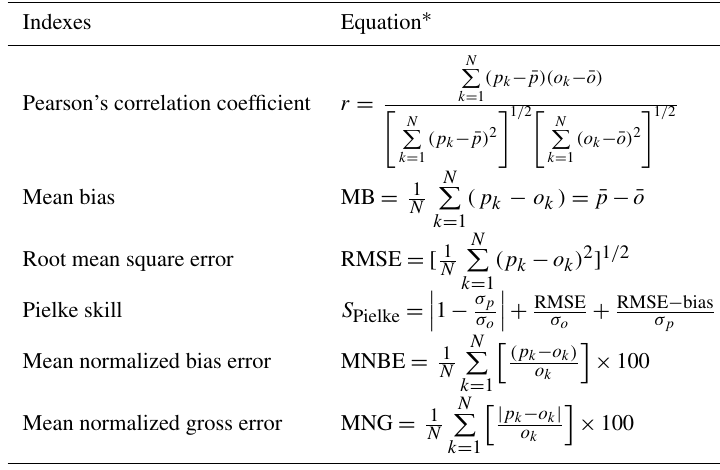
Biogenic and doubled mobile and stationary sources Table 5. Statistical indexes used to evaluate the model performance.